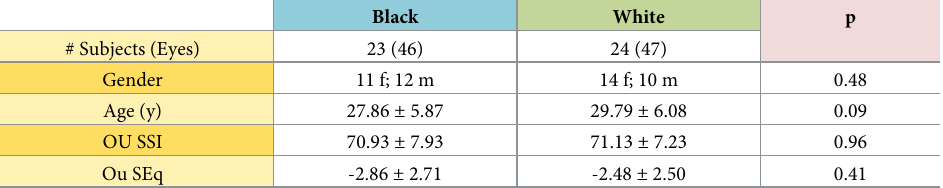
Table 1. Characteristics of the subject groups. Black White p # Subjects (Eyes) 23 (46) 24 (47) Gender 11 f; 12 m 14 f; 10 m 0.48 Age (y) 27.86 ± 5.87 29.79 ± 6.08 0.09 OU SSI 70.93 ± 7.93 71.13 ± 7.23 0.96 Ou SEq -2.86 ± 2.71 -2.48 ± 2.50 0.41 Data are presented as means ± standard deviation. f = female, m = male, OU = both eyes, SSI = signal strength intensity, SEq = spherical equivalent. Wilcoxon (Mann-Whitney) rank-sum test used to compare the study groups by